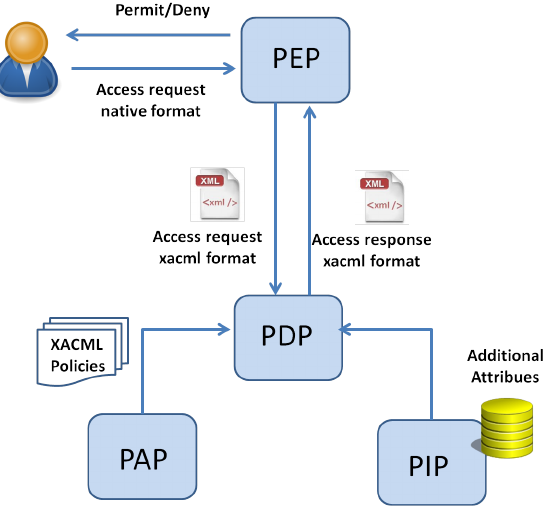
Figure 1. XACML Basic